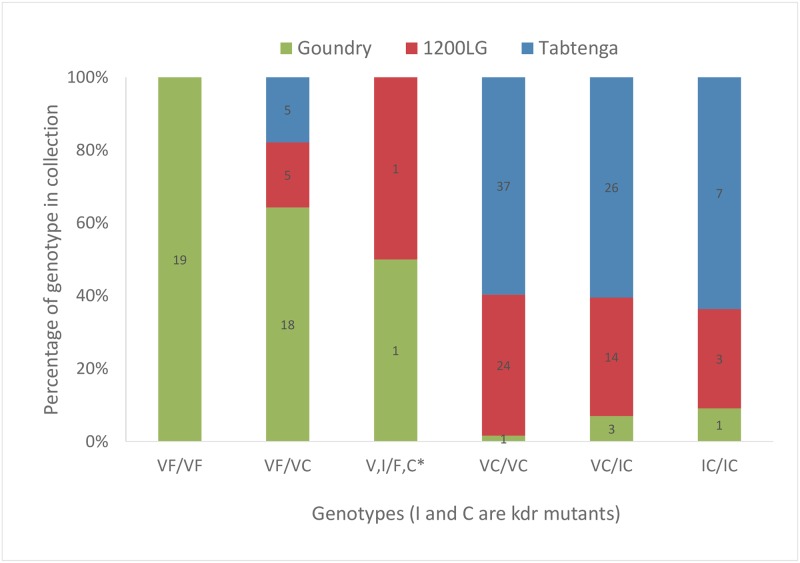
Genotype frequencies at the VGSC mutation positions V1016I and F1534C in females from each collection location.Inset numbers show the number of genotypes detected. VF/VF is wild type and VF/VC contains only one mutant allele; all other genotypes contain at least two mutant alleles. *heterozygote at each position, therefore genotypes could not be determined.